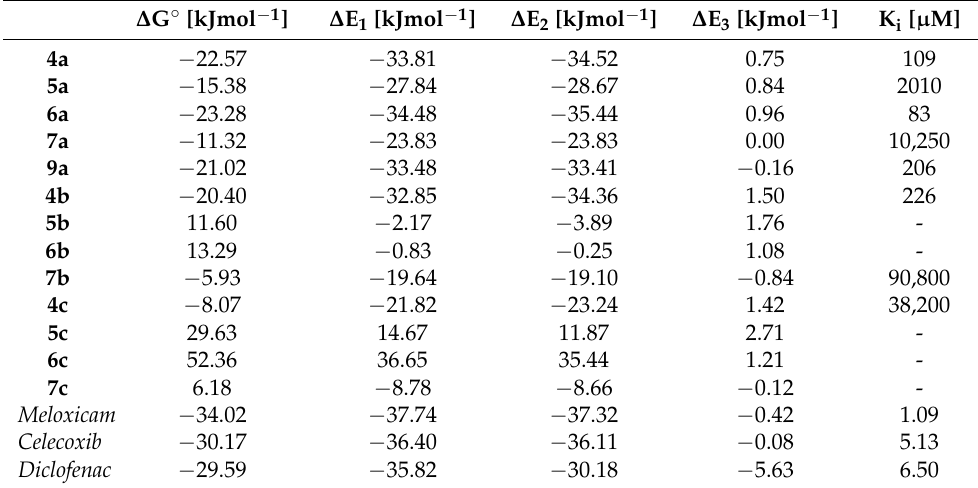
Table 3. Energies of the interactions of the tested compounds with COX-2 were obtained from the molecular study.